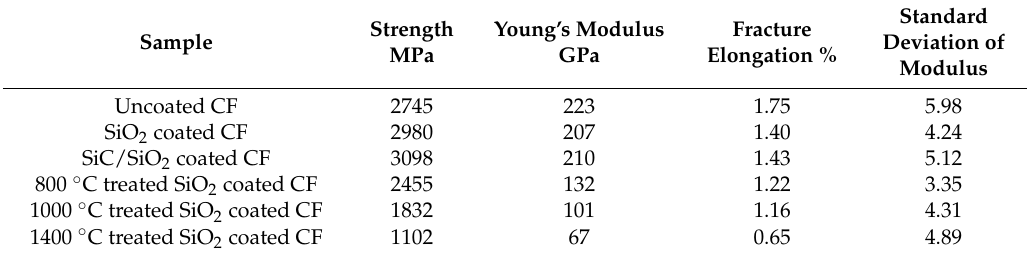
Table 2. Mechanical property of different